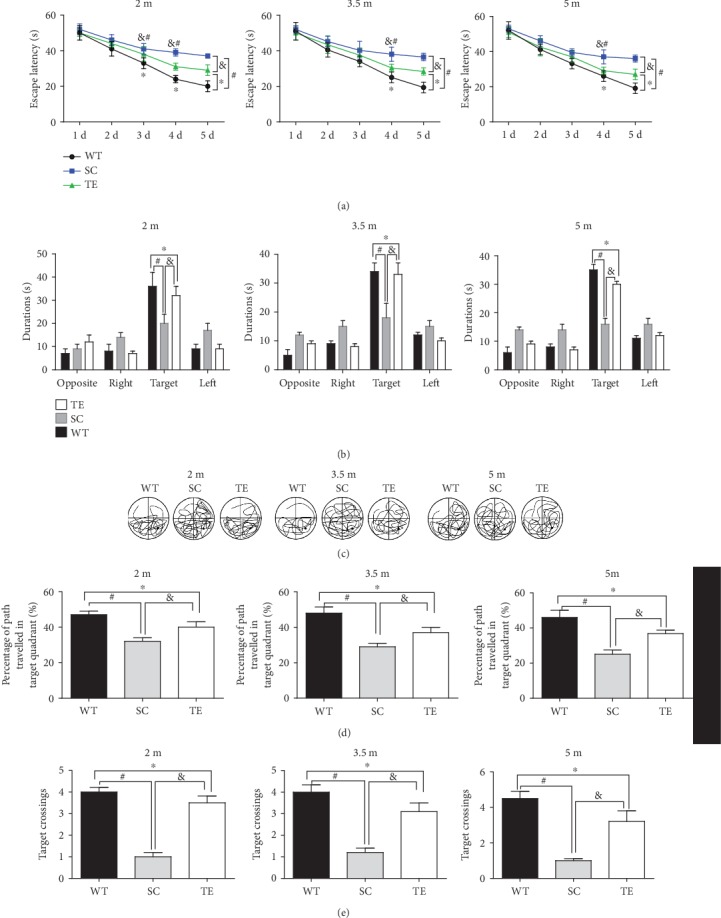
Early 12-week treadmill exercise improved spatial learning and memory in APP/PS1 mice. In the hidden platform test, the escape latencies of WT or APP/PS1 mice over 5 d were recorded (a). In the probe test, the percentage of time spent in the target quadrant (b), typical probe traces (c), percentage of path traveled in the target quadrant (d), and number of target crossings (e) for 2 m, 3.5 m, and 5 m WT and APP/PS1 mice with or without exercise and WT mice were compared. WT: wild type; SC: sedentary control; TE: treadmill exercise. ∗WT vs. TE, P < 0.05; #WT vs. SC, P < 0.05; &TE vs. SC, P < 0.05.